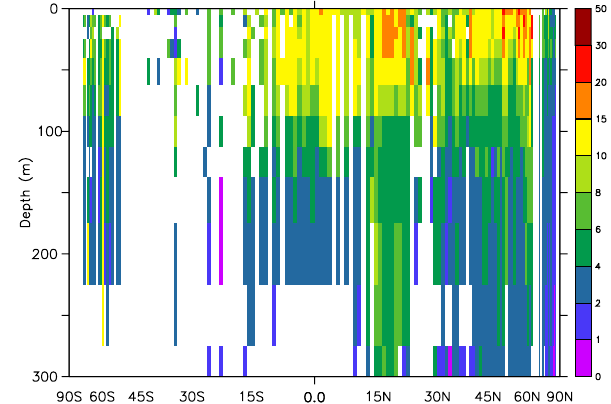
Figure 4. Picoheterotroph biomass ( µ gCl − 1 ) averaged over all available longitudes and months in the top